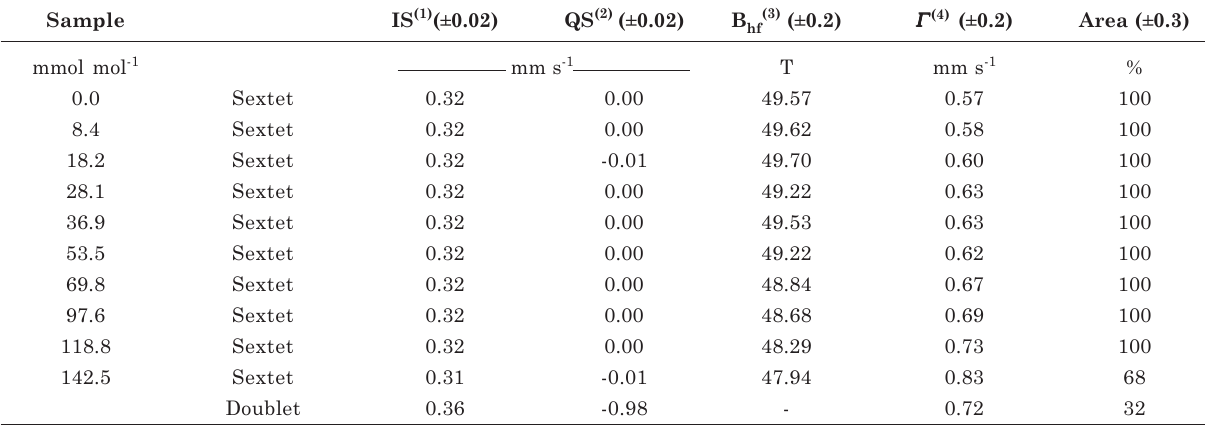
(1) Relative to α -Fe foil at room temperature; (b) quadrupole splitting; (c) magnetic hyperfine interaction; and (d) linewidth.